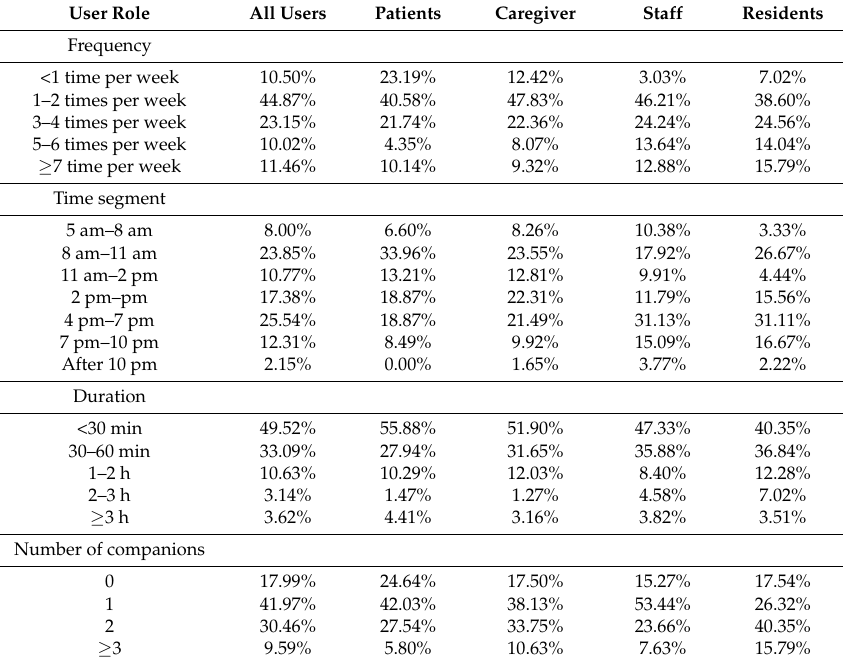
Table 3. Respondents’ use of the current hospital outdoor